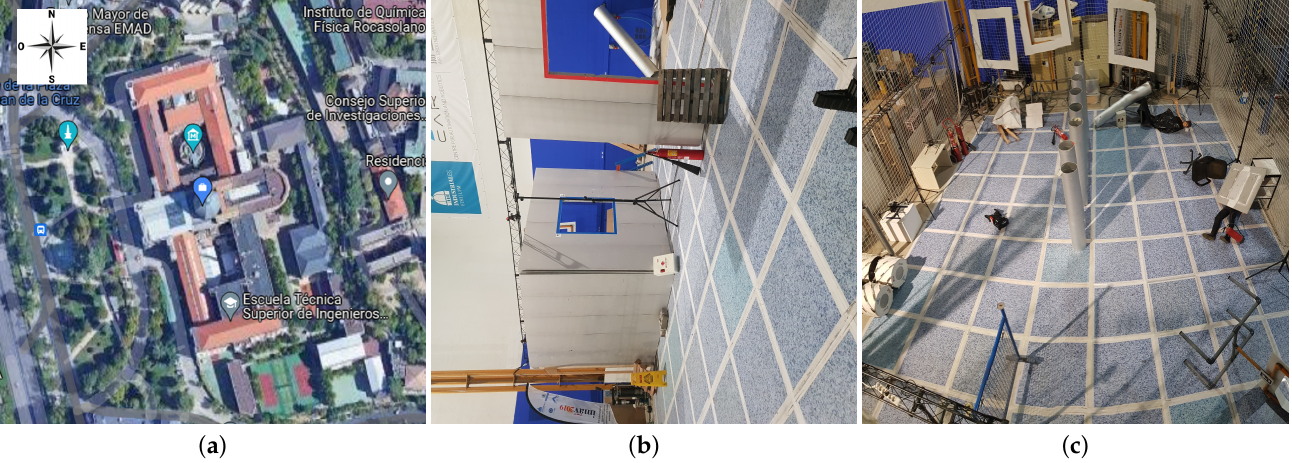
Figure 1. Indoor and outdoor scenarios are used for test development. ( a ) ETSII-UPM Outdoor Testing Environment. ( b ) Scenarios recreated for indoor testing. ( c ) Scenarios recreated for indoor testing—top view. Source: Authors.